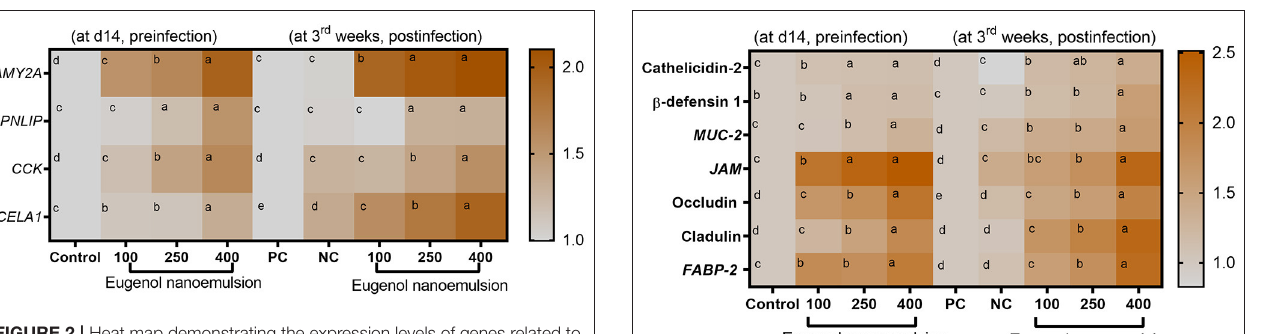
FIGURE 2 | Heat map demonstrating the expression levels of genes related to digestive enzymes; AMY2A (alpha 2A amylase), PNLIP (pancreatic lipase, CCK (cholecystokinin), and CELA1 (chymotrypsin-like elastase family, member 1) in the pancreas of broiler chickens received different levels of eugenol nanoemulsion pre- (at day 14) and post- (at 3rd week) E. coli O78 challenge detected by RT-qPCR technique. Values are means with their SE. The intensity